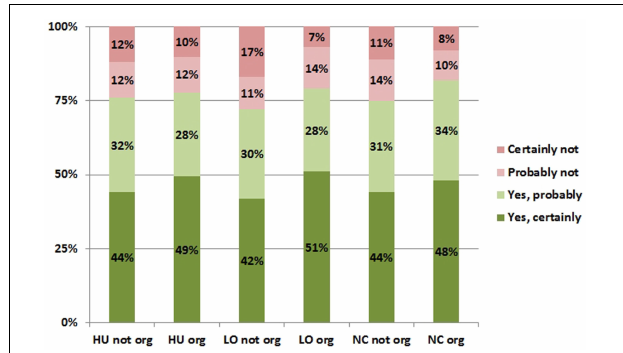
FIGURE 6 | “Do you believe that an increase of wolf populations could be managed to your satisfaction?” – Response behavior grouped according to institutionally organized (org) and non-institutionally organized (non-org) respondents to Q3 (HU n = 413, LO n = 305, NC n = 606).